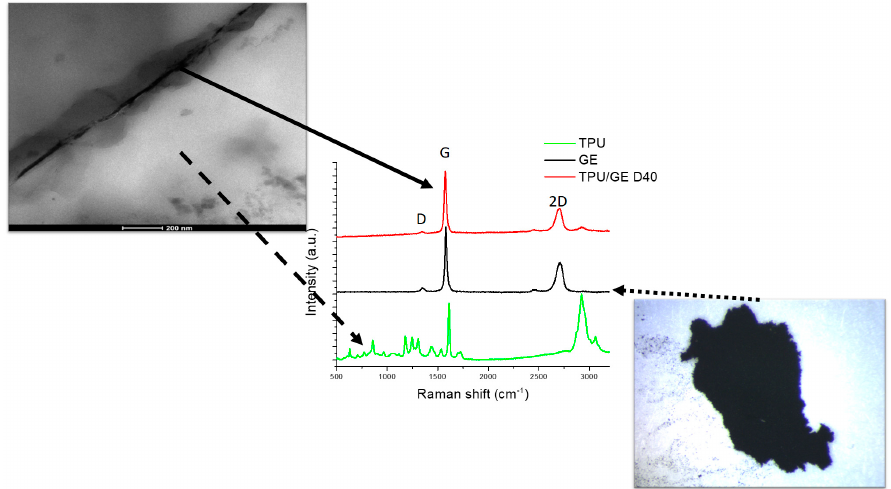
Figure 4. Raman spectra of GE powder (black line), and TPU (green line) and GE (red line) in the TPU/GE G40 composite after SLS